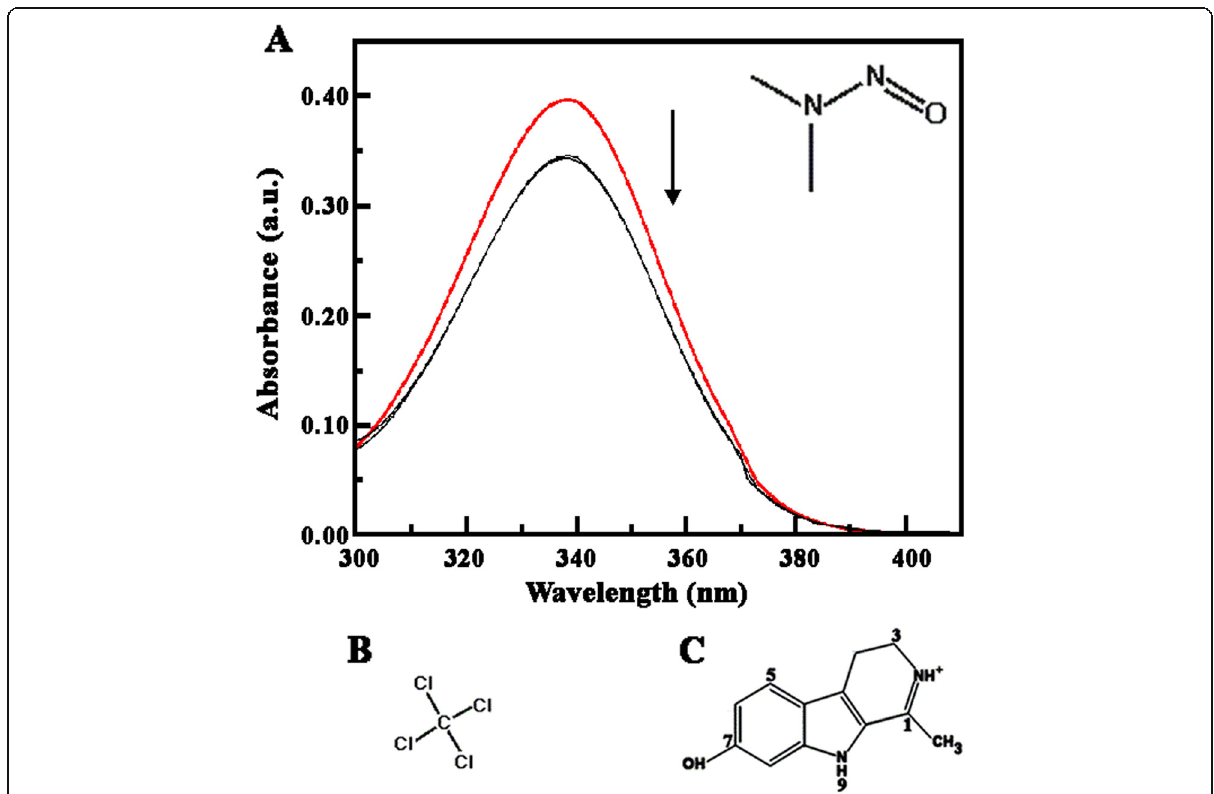
Fig. 1 A representative figure (top panel) showing the DNA-adduct formation by DEN upon titration with CT DNA. Chemical structure of a (inset) DEN, b